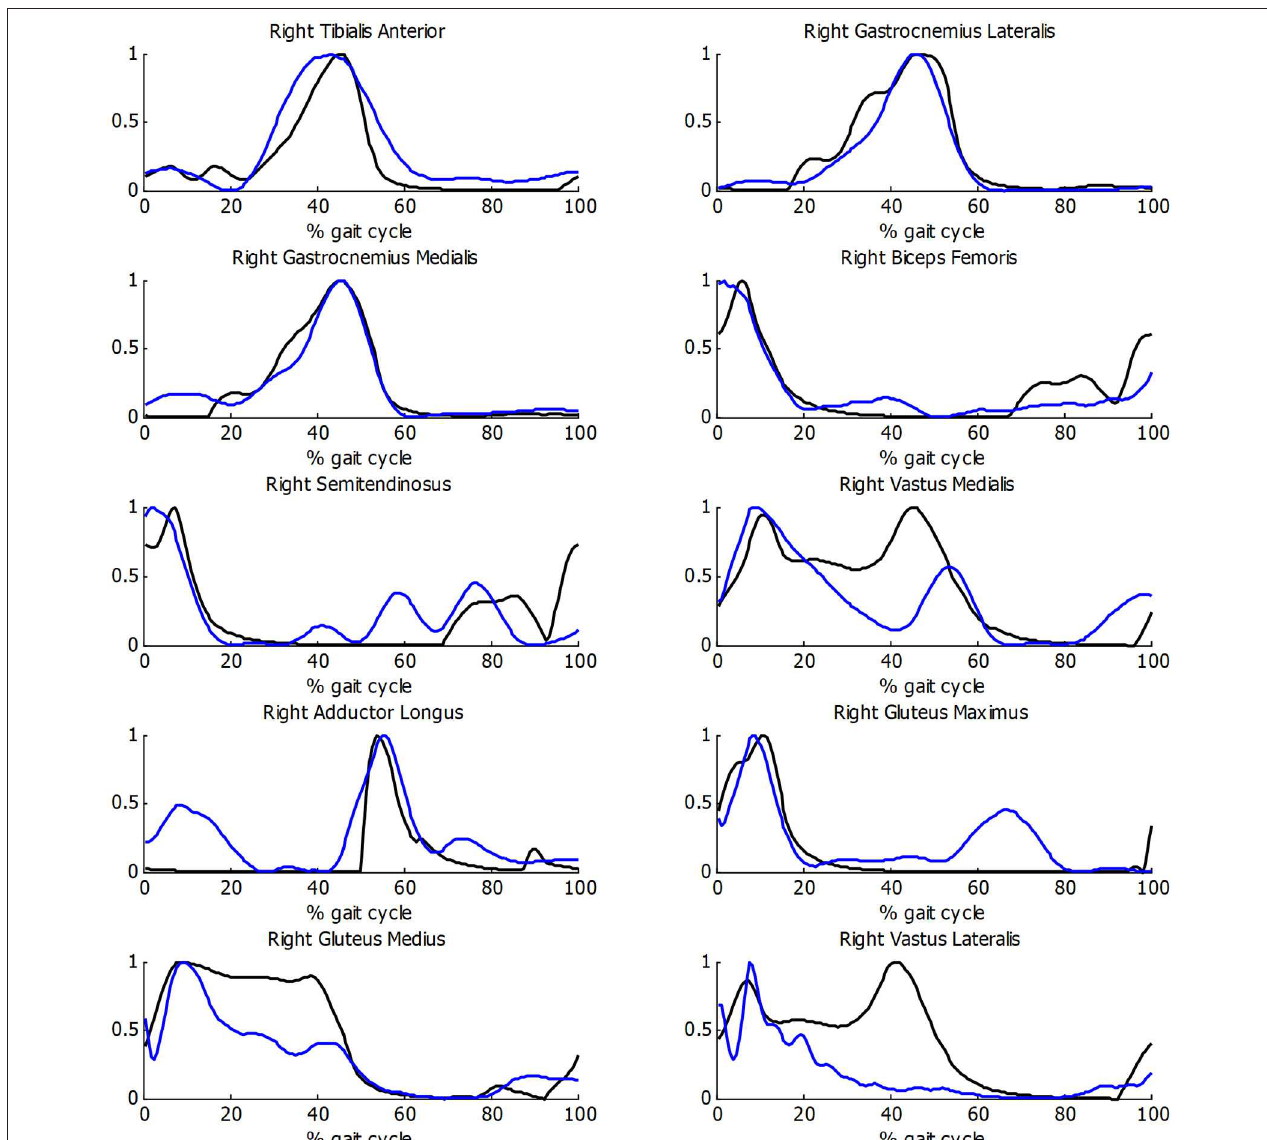
FIGURE 5 | Comparison of normalized muscle activations (black) and normalized EMG measurements (blue) during gait for healthy